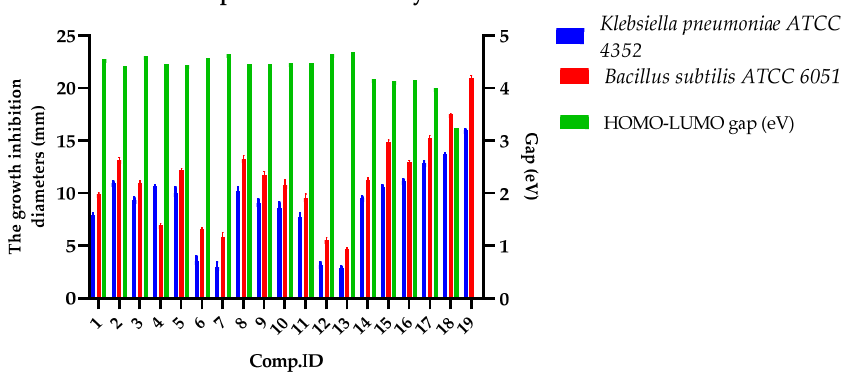
Figure 5. Antimicrobial assay results (qualitative) for tested compounds 1–18 as (SM-IMP-01) to SM-IMP-13), and (DA-01-05), respectively. Wherein, 19 was used as a standard drug, ciprofloxacin.